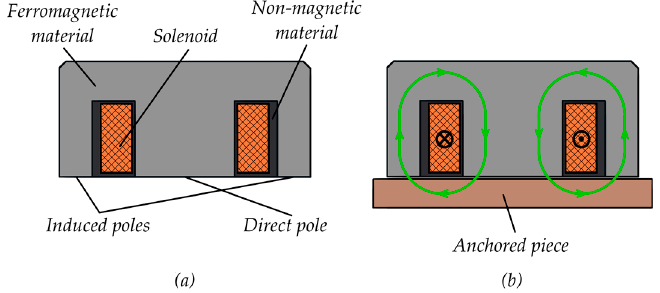
Figure 1. The typical EM configuration in ( a ) rest and ( b ) working conditions.